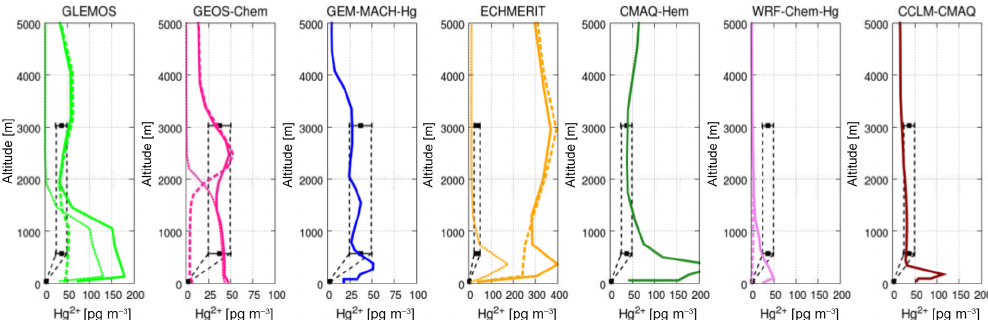
Figure 7. GOM profiles at Waldhof Germany (23 August 2013) (Weigelt et al., 2016). The observations are a combination of ground-based measurements and a total column measurement in altitudes from 500 to 3000m. Model values are given for BASE (solid line), ANTSPEC (dashed line), and NOCHEM (dotted line).